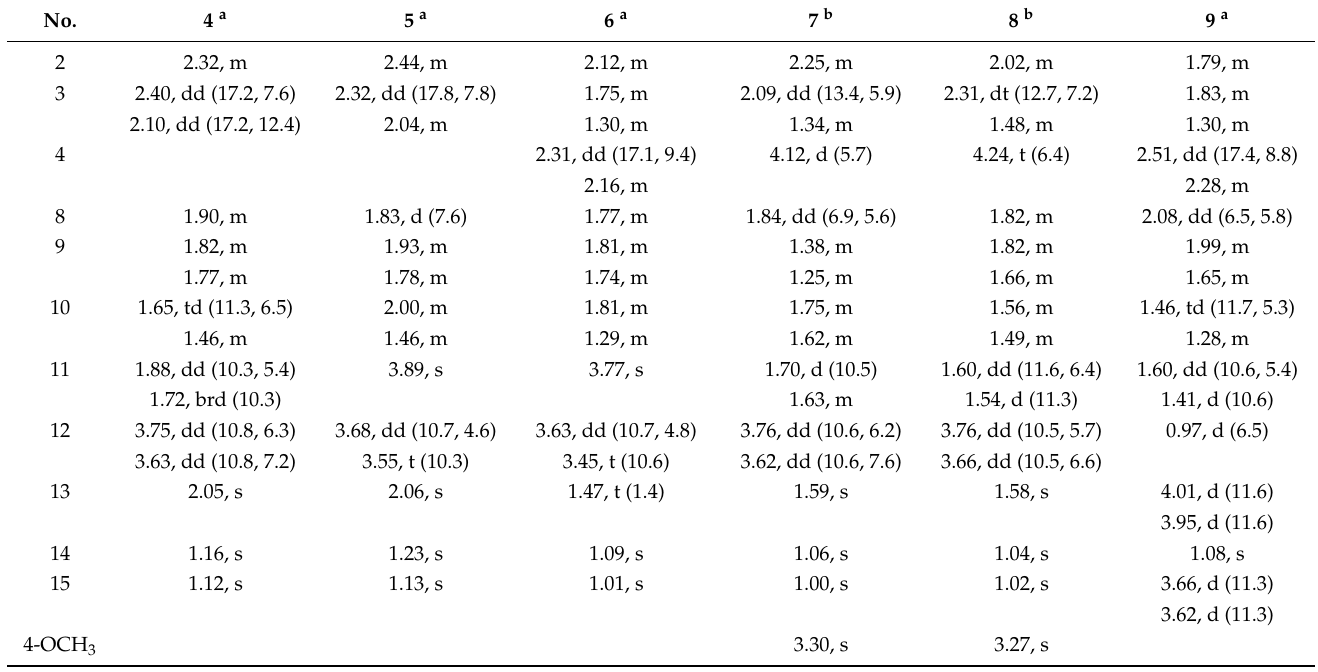
(Figure 2). HMBC correlations from Me-13 to C-5 ( δ C 214.6), C-6 and C-7 ( δ C 39.0), from both Me-15 and Me-14 to C-6, C-7 and C-8, from H-2, H-11 and H 2 -10 to C-1 ( δ C 60.2), from H-4 to C-11, C-2, and C-12, and from H-10b ( δ H 1.63) to C-5 established the planar structure of 3 with bicyclo [3.2.1]octane core and acetal group at C-4. The relative configuration of 3 was deduced by NOEs between H-11/Me-15, H-11/H-12a ( δ H 4.02), H-11/H-8, H-6/H-10b ( δ H 1.63), H-6/Me-14, H-2/H-3b ( δ H 1.59), H-4/H-3b, and H-3a ( δ H 2.25)/H-10a ( δ H 2.14) as shown (Figure 3). Compound 4 was isolated as a colorless bulk crystal. The molecular formula of compound 4 was determined as C 15 H 26 O 3 by HRESIMS. The NMR data of 4 (Tables 3 and 4) were similar to those of albaflavenone, except for the presence of oxygenated methylene ( δ H 3.75, 3.63 and δ C 63.9, CH 2 -12). 6 The existence of 12-OH was confirmed by COSY correlations between H 2 -12/H-2 ( δ H 2.32)/H 2 -3 ( δ H 2.40 and 2.10) together with HMBC correlations from H 2 -12 to C-1 ( δ C 52.0), C-2 ( δ C 42.1) and C-3 ( δ C 43.8) (Figure 2). The remaining substructures and the relative configuration of 4 were shown to be identical to those of albaflavenone by detailed analysis of the 2D NMR spectra (Figures 2 and 3). Table 3. 1 H NMR spectroscopic data of compounds 4 – 9 (500 MHz, δ in